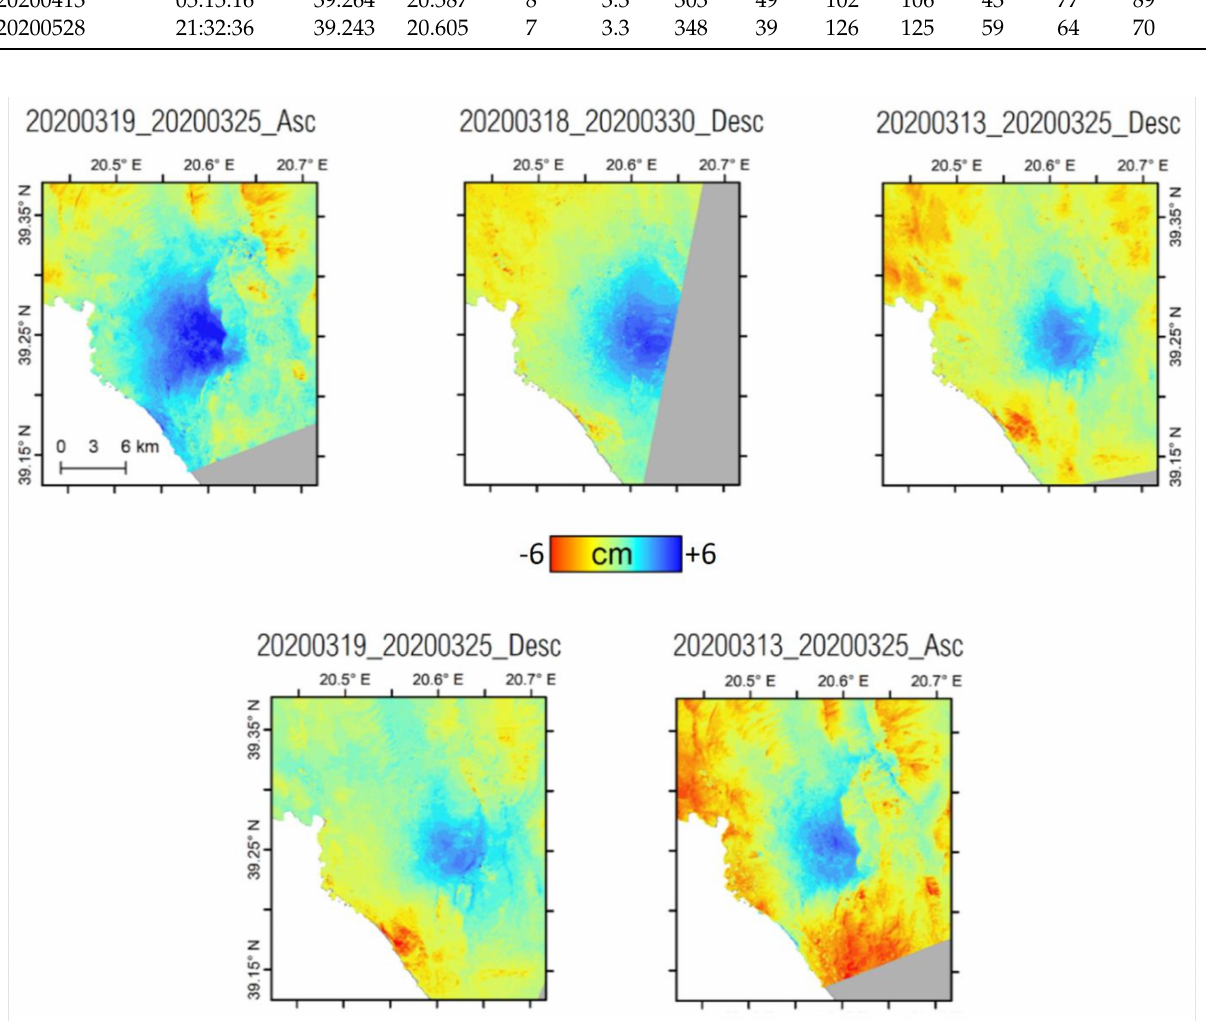
Figure 3. InSAR Line-of-Sight (LoS) surface displacement results from both the ascending and descending acquisition geometries (YYYYMMDD). “Asc” and “Desc” stand for Ascending and Descending, respectively. The detected uplifting pattern is in accordance with the thrust component indicated by the focal